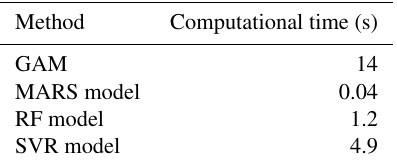
Table 3. Summary of the computational time of each model.